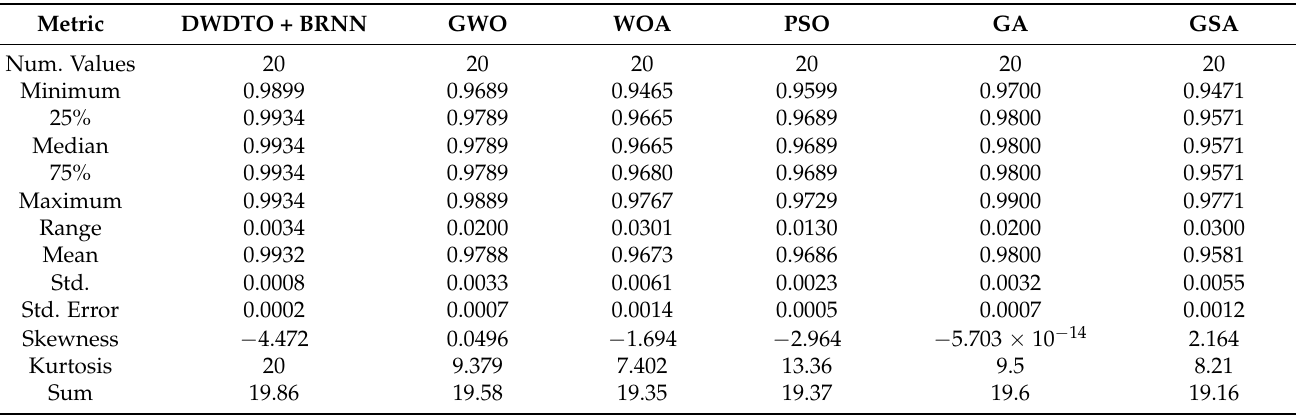
Table 11. Statistical analysis of the achieved results using the proposed DWDTO applied to the second dataset (D2).